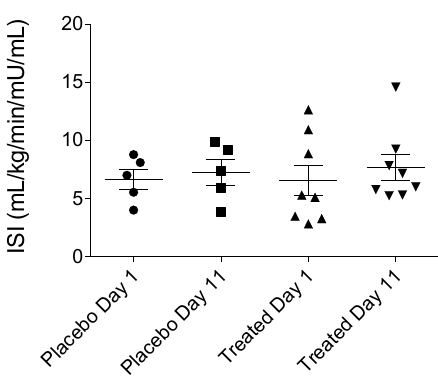
Figure 6. Insulin sensitivity index of the placebo- and fenugreek-treated subjects.